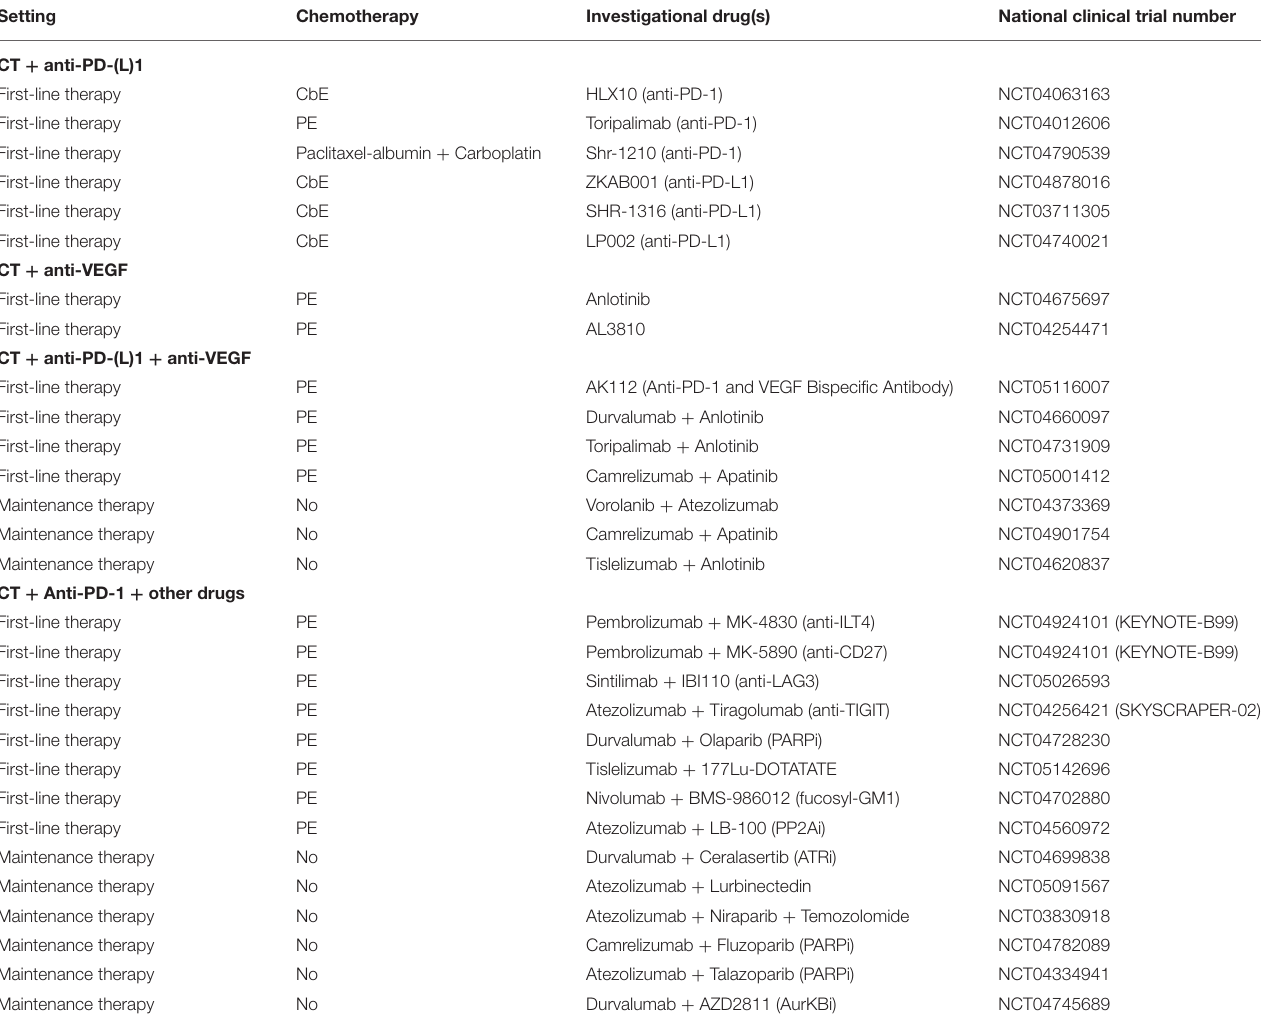
TABLE 2 | Ongoing clinical trials evaluating new combination strategies as first-line or maintenance therapy.